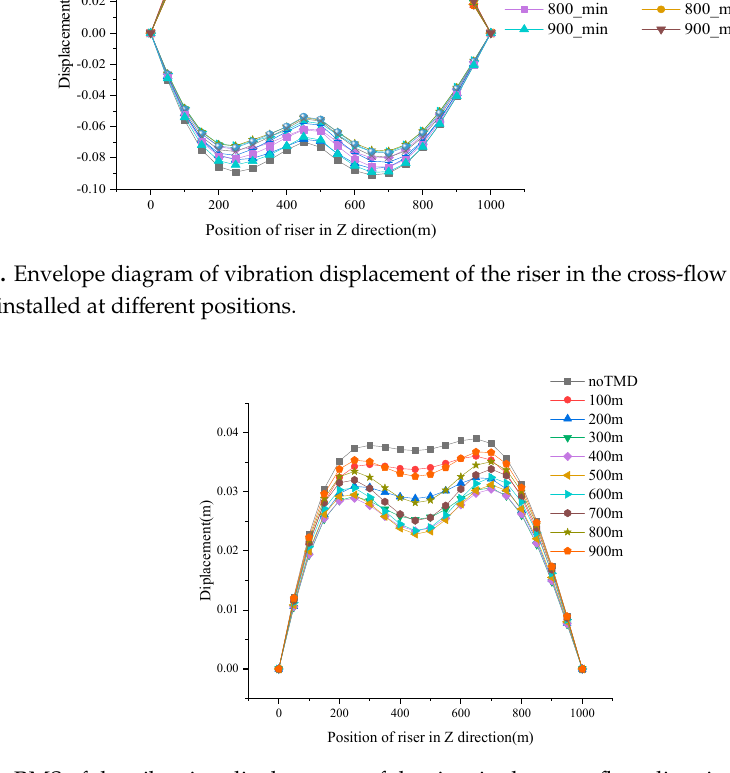
Figure 6. RMS of the vibration displacement of the riser in the cross-flow direction when the TMD is installed at di ff erent installed at different positions.